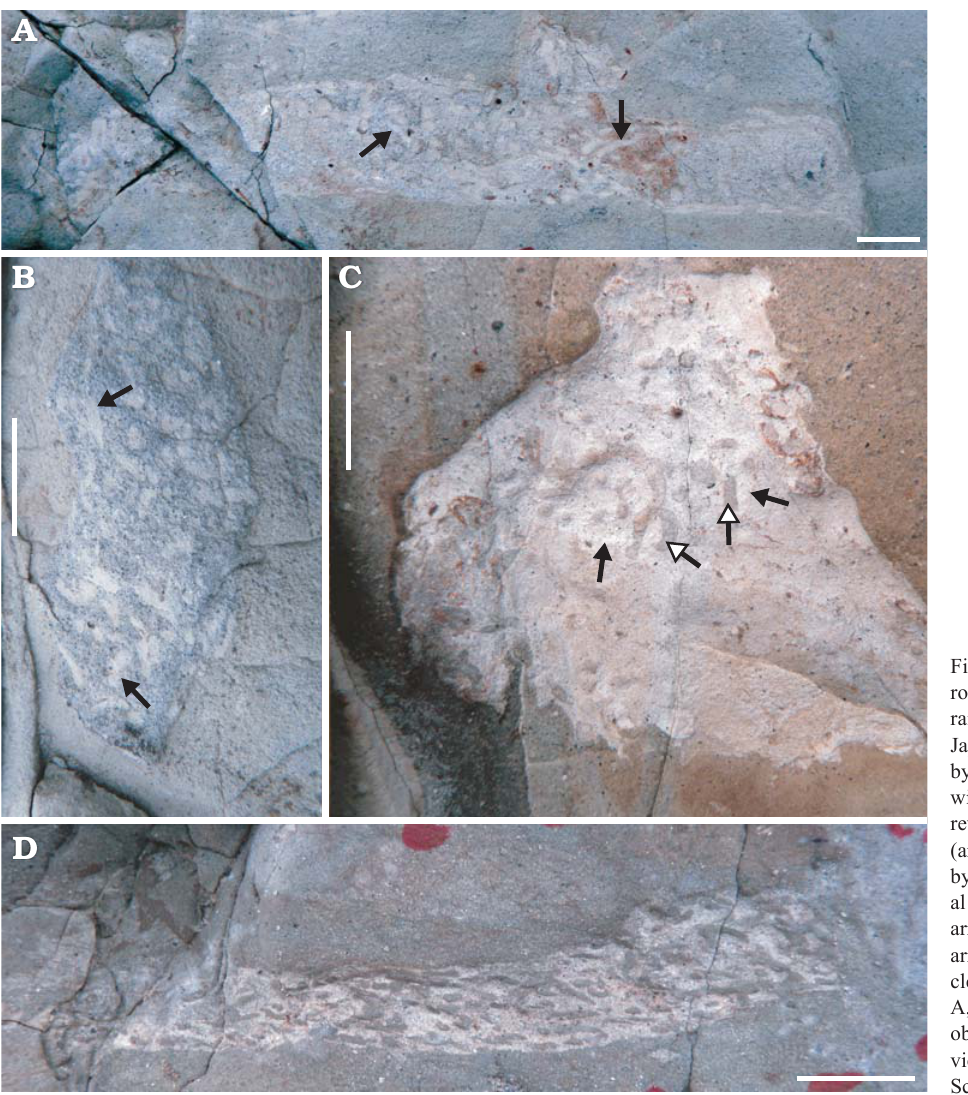
Fig. 3. Composite Phymatoderma bur- rows from the Shiramazu Formation, Hi- raiso section, Chiba Prefecture, central Japan. A , B . Phymatoderma reworked by Chondrites . Phymatoderma tunnels with dark gray-colored scoriaceous infill reworked by white-colored Chondrites (arrows). C , D . Phymatoderma reworked by Phycosiphon . Even within the pellet- al infill of Phymatoderma , cores (white arrows) and surrounding mantles (black arrows) of Phycosiphon are sometimes clearly recognized ( C ). Field photos; A, B, parallel to the bedding plane; C, obliquely cut vertical cross-sectional view; D, vertical cross-sectional view. Scale bars 10